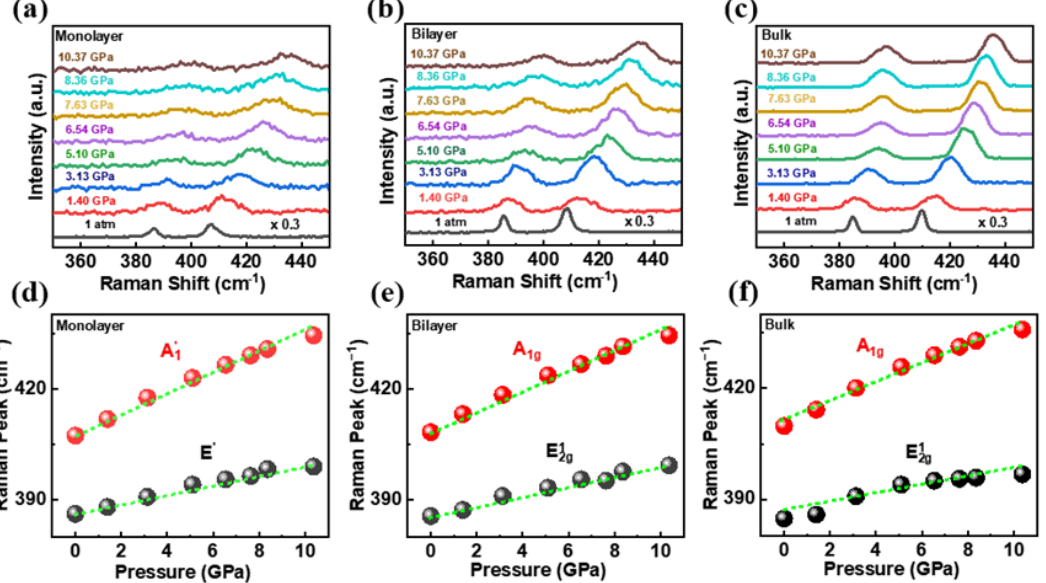
Figure 2. Raman spectra of ( a ) monolayer, ( b ) bilayer, and ( c ) bulk MoS 2 at different pressures. ( d – f ) Raman peaks of monolayer, bilayer and bulk MoS 2 as a function of pressure.